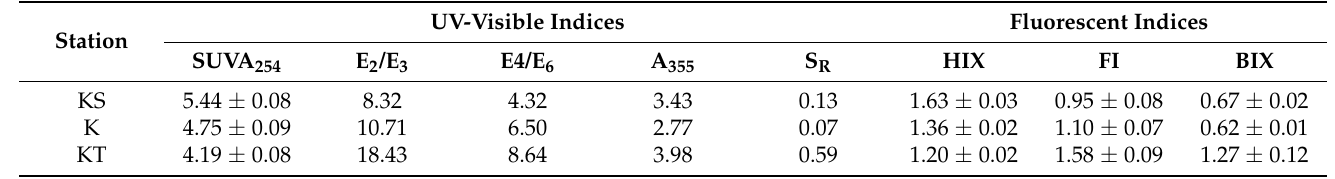
Table 4. UV-visible and fluorescent spectroscopy indices of the DOM extracted from three sedi- ments.